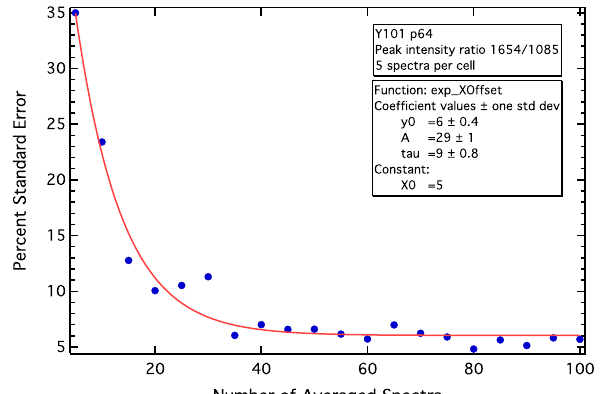
Figure 8. Example percentage standard error (%SE) convergence test showing the “decay” of the %SE associated with the 1654/1085 PIR as a function of increasing, randomly-acquired spectra added to the spectral average. A convergence test such as this can be used to derive a decay constant (tau/ τ ), interpreted as a quantitative measure of heterogeneity stratified to specific PIRs. The red line shows the fitted exponential function.